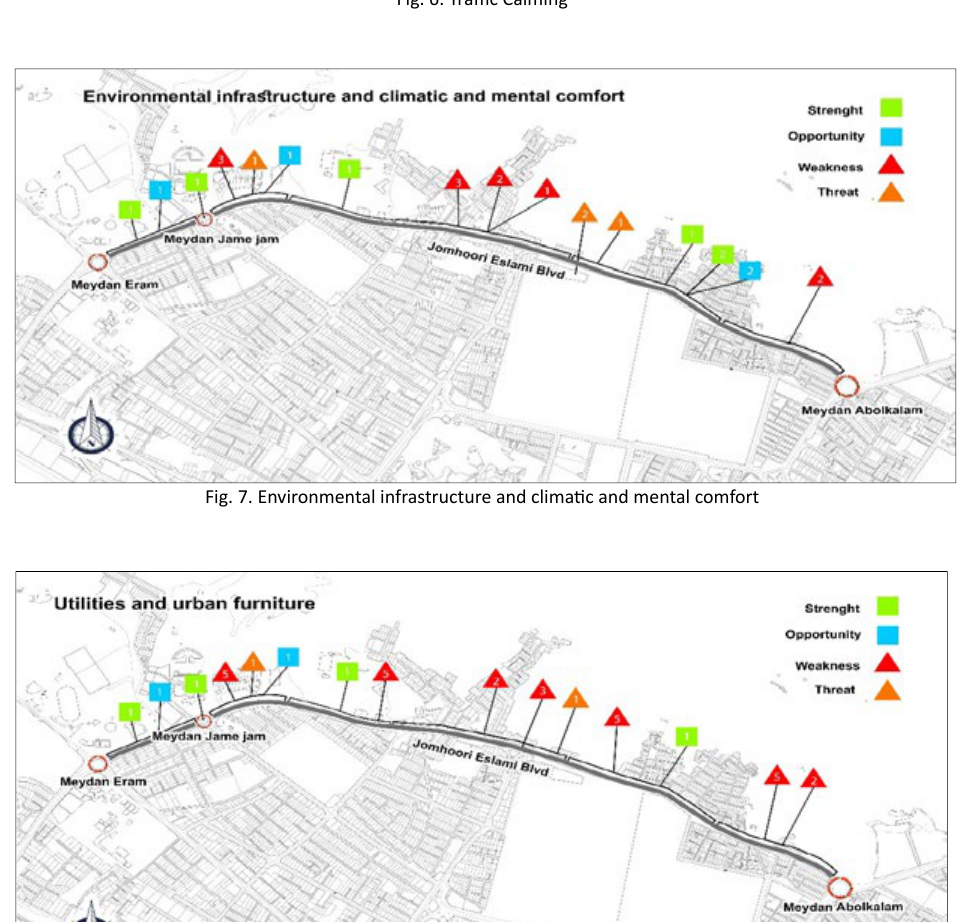
Fig. 6. Traffic Calming Fig. 7: Environmental infrastructure and climatic and mental comfort